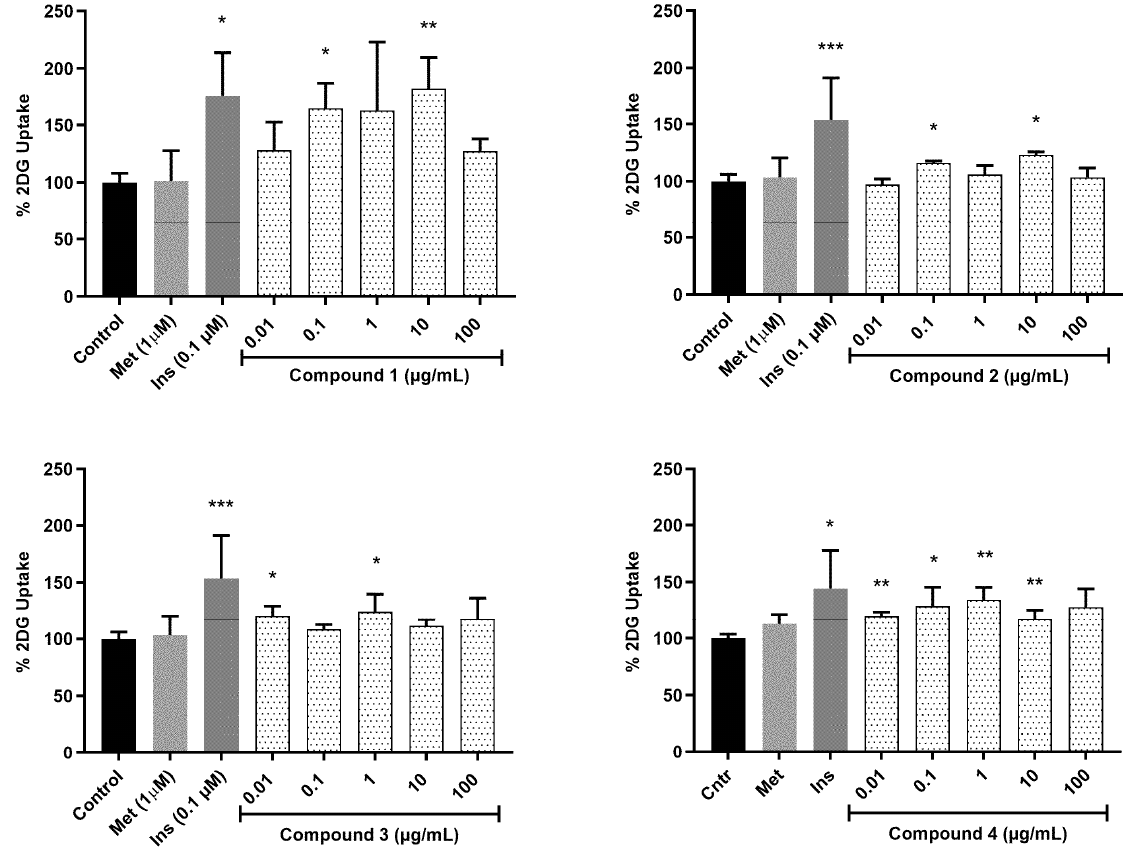
Figure 1. Glucose uptake in C2C12 myocytes. Glucose uptake activity % estimated from 2-deoxy-D-glucose uptake in C2C12 myocytes exposed to the Marula leaf extracts at different concentrations over one hour. The percentage is expressed relative to the control set at 100%. Insulin (Ins) and metformin (Met) were included as positive and drug reference controls, respectively. p value, * p < 0.05, ** p < 0.01, *** p < 0.001. The MTT cell viability assay was carried out for the two most active extracts (aqueous extracts 1 and 4) (see Figure 2). Aqueous extract 1 only decreased cell viability at the highest concentration of 100 µg/mL after 72 h of exposure. Aqueous extract 4 induced decreased cell viability at all tested concentrations by 25% while it also significantly induced decreased cell viability at 100 µg/mL by 80%. It is therefore established that the extracts become cytotoxic to the cells above a concentration of 10 µg/mL.